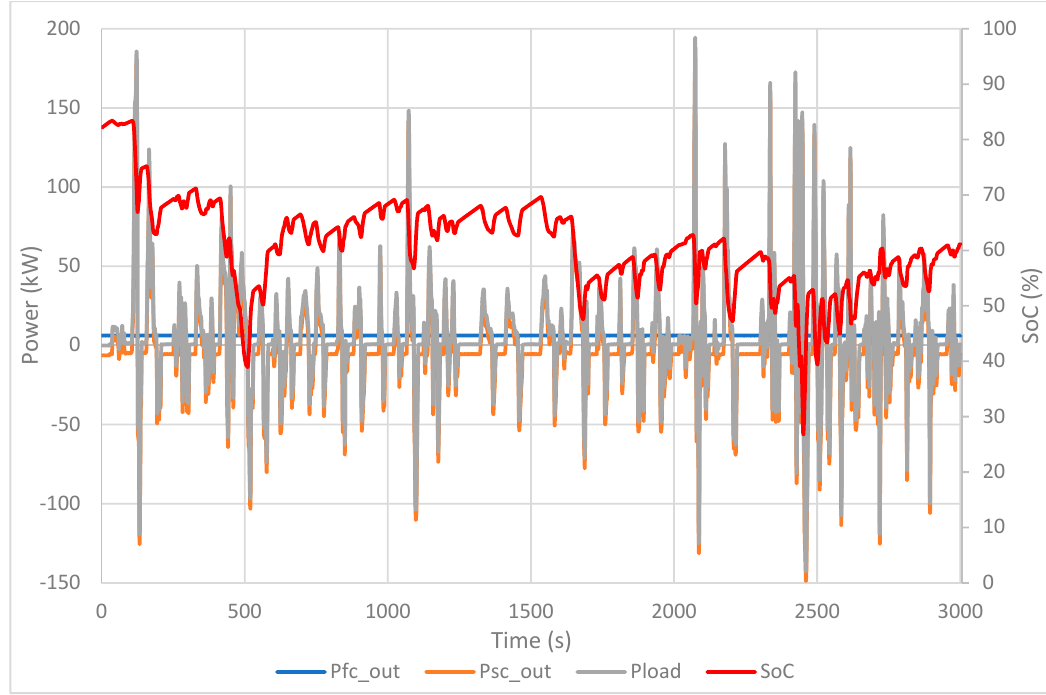
Figure 10. Power balancing and SoC change of the bus journey with the lowest average power.